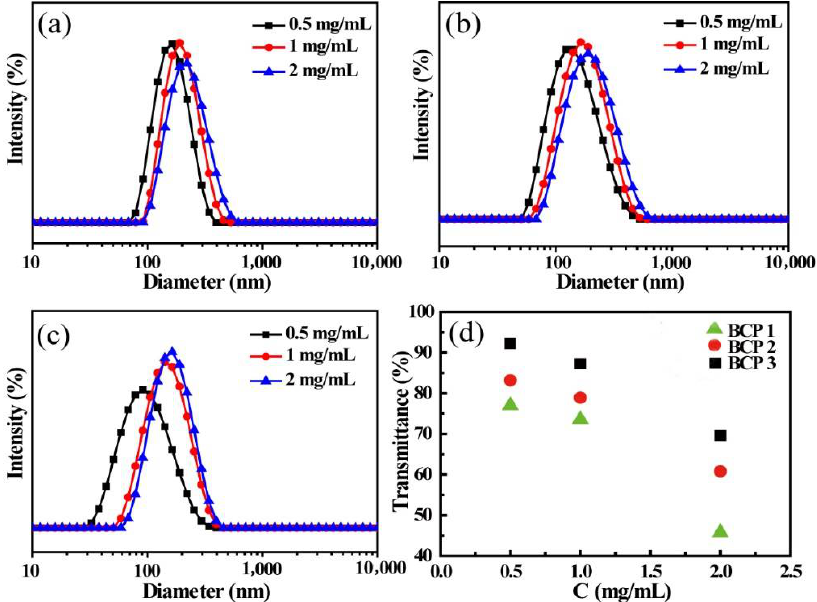
Figure 2. DLS curves of BCP1 ( a ), BCP2 ( b ) and BCP3 ( c ) micelles at various initial concentration of 0.5 mg/mL, 1 mg/mL and 2 mg/mL; ( d ) optical transmittance at 500 nm with different concentration for BCP1, BCP2 and